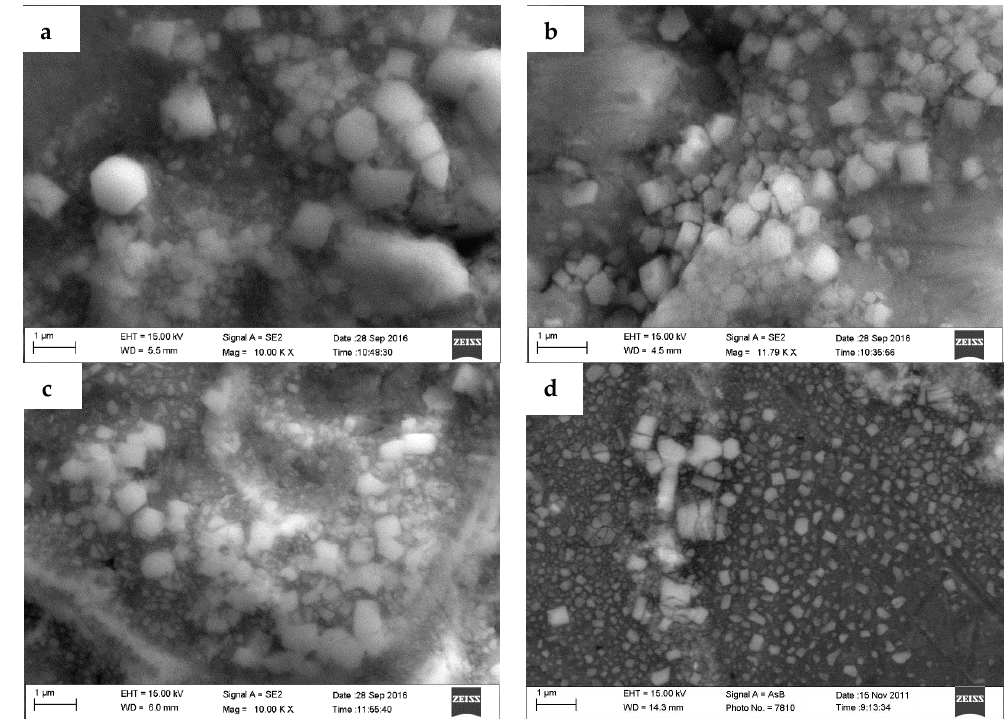
Figure 7. The micrograph of TiB 2 particles in the composites. ( a ) 3.0% TiB 2 /7075; ( b ) 4.5% TiB 2 /7075; ( c ) 6.0% TiB 2 /7075; ( d ) 9.0% TiB 2 /7075.